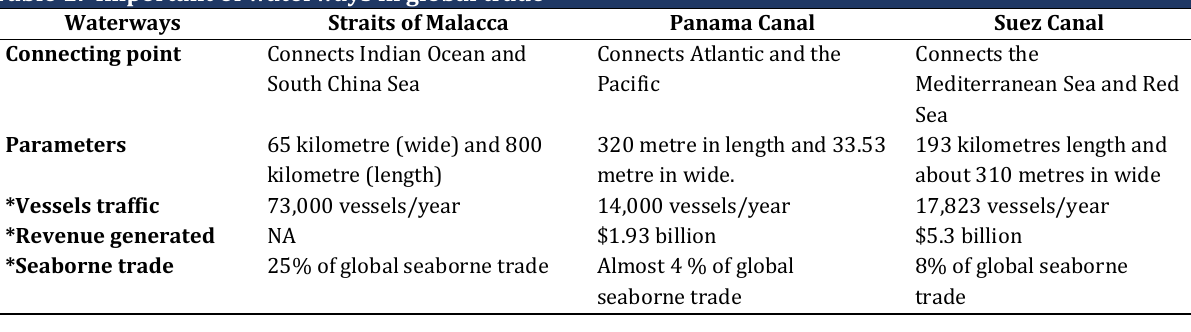
Table 1: Important of waterways in global trade